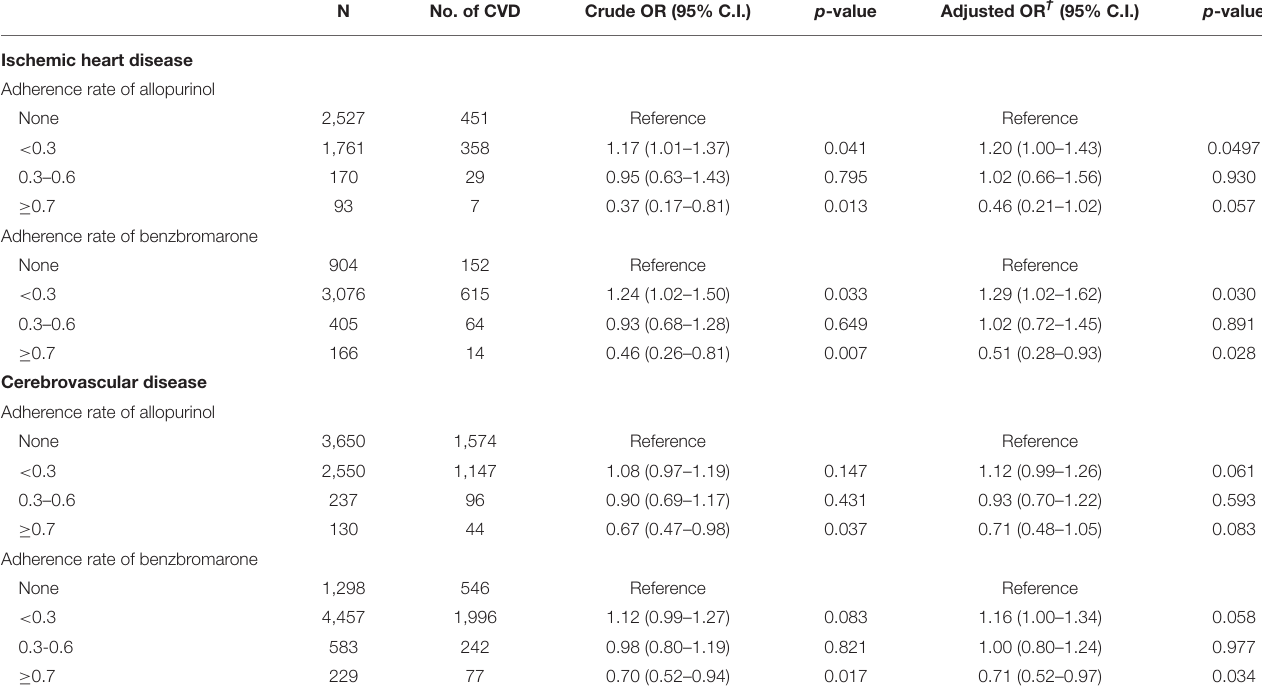
TABLE 5 | Sub-outcome of logistic regression of risk of CVD. N No. of CVD Crude OR (95% C.I.) p -value Adjusted OR † (95% C.I.) p